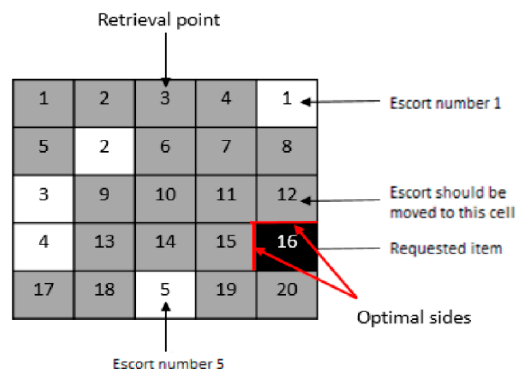
Figure 11. Example 2.